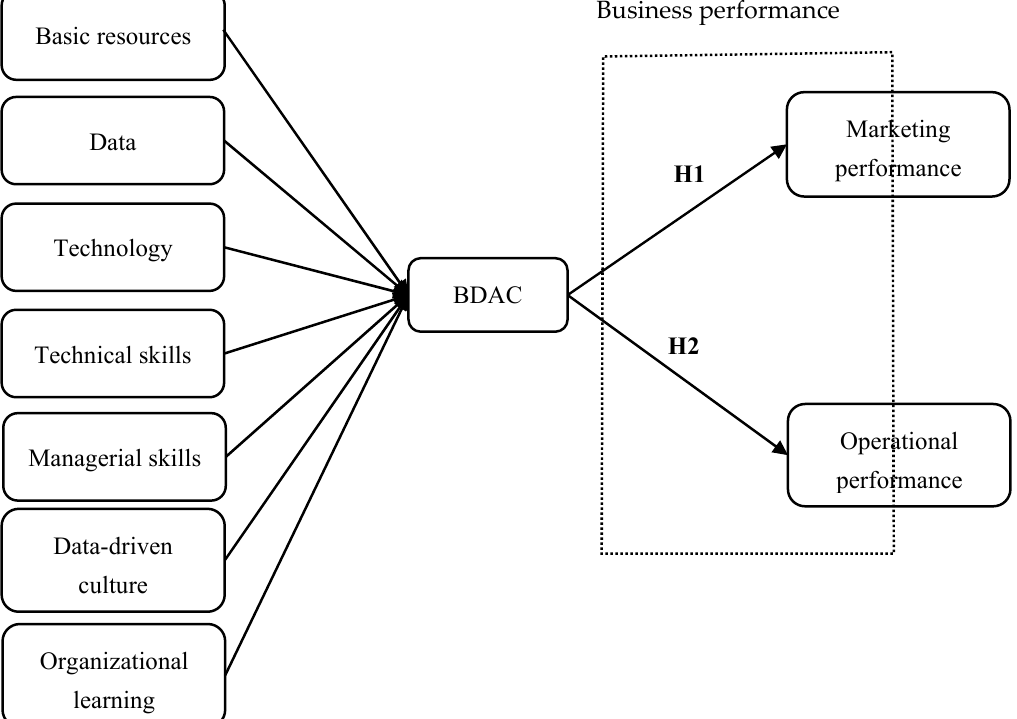
Figure 1. Conceptual framework and proposed hypotheses.